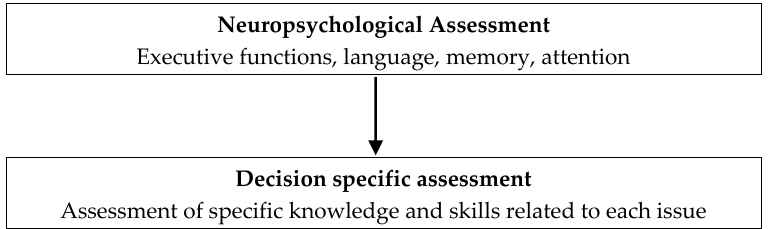
Figure 1. Flow chart of the approach to assess decision making capacity. Table 1. Comparison of the neuropsychological profiles of two patients.